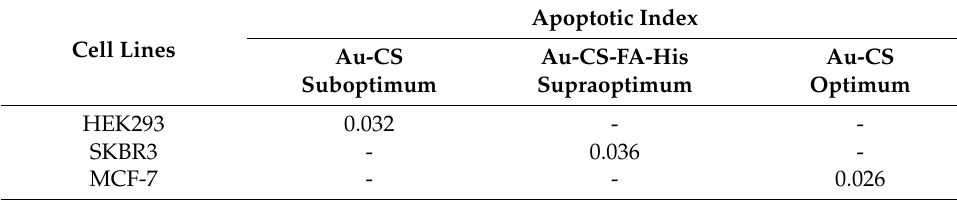
Figure 8. Fluorescent images from the acridine orange/ethidium bromide apoptosis assay in the HEK293, SKBR3 and MCF-7 cell lines at 20 × magnification. Control = untreated ( A ) HEK293 ( B ) SKBR3 and ( C ) MCF-7 cells. FAuNP treated cells ( D ) HEK293 cells with Au-CS at the suboptimum ratio, ( E ) SKBR3 cells with Au-CS-FA-His at the supraoptimum ratio and ( F ) MCF-7 cells with Au-CS at the optimum ratio. Scale bar = 100 µm. Table 3. Apoptotic indices of the